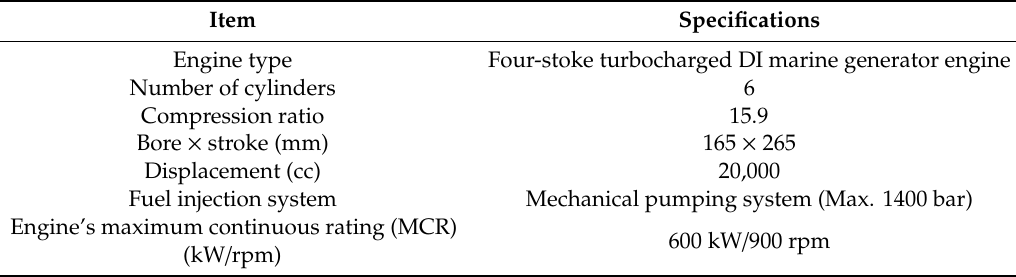
Figure 1. Schematic of the four-stroke marine engine. Table 1. Specifications of the test engine.